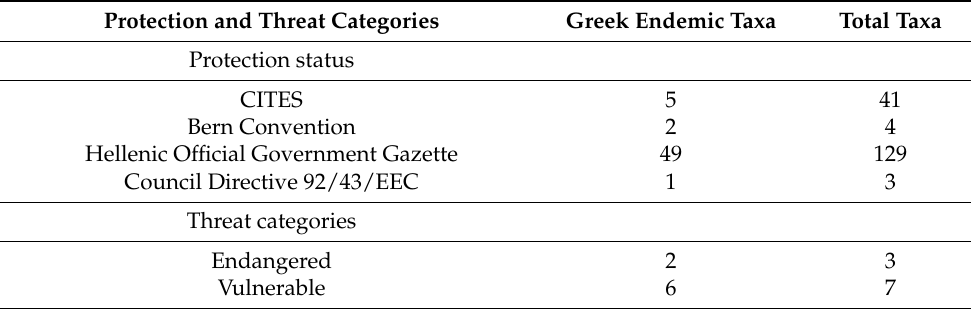
Table 4. Protection Status and threat categories of CVNP’s vascular plants.